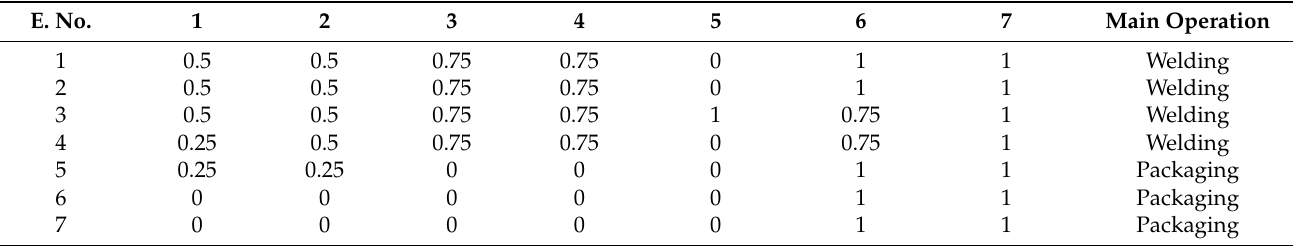
Table 1. Matrix of